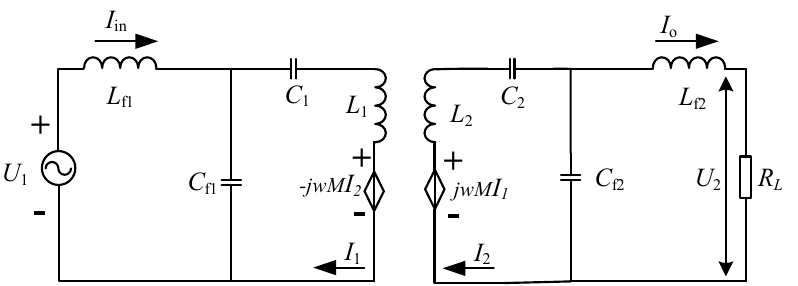
Figure 15. General block diagram of the system.